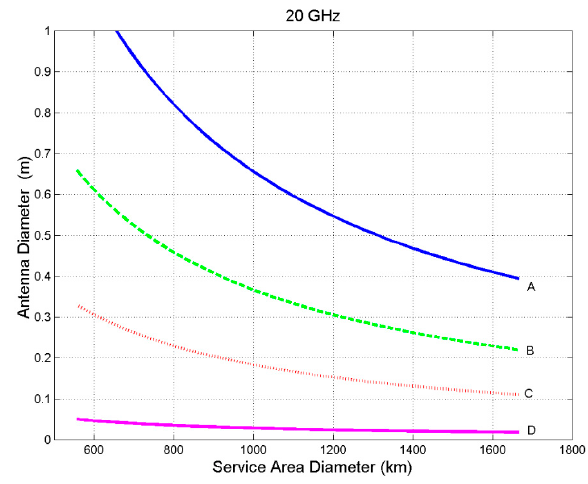
Figure 6. Antenna diameter as a function of the service area diameter, at 20 GHz for the GeoSurf constellation. A refers to ℎ = 35,876 km; B to ℎ = 20,000 km; C to ℎ = 10,000 km, D to ℎ = 1500 km.